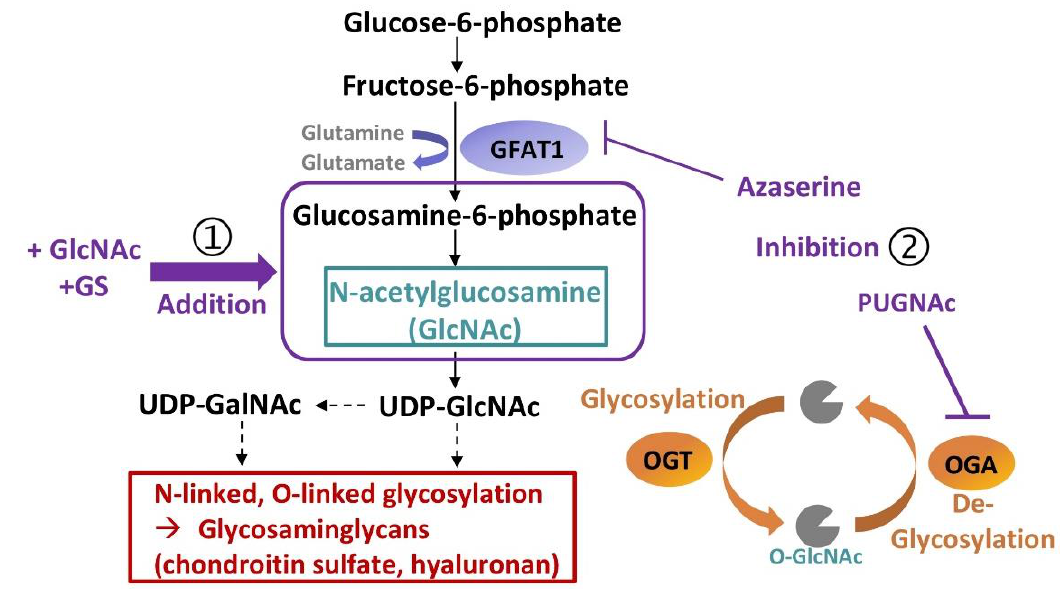
Figure 1. Schematic illustration of the hexosamine biosynthetic pathway (HBP), its role in glycosaminoglycan synthesis and potential therapeutic targeting. In the present study, the HBP is targeted in different ways: (1) glucosamine derivatives (N-acetylglucosamine (GlcNAc) or glucosamine sulfate (GS)) were added at different concentrations to enhance the bioavailability of the substrate for uridine diphosphate GlcNAc (UDP-GlcNAc) generation; (2) the rate-limiting enzyme, glutamine fructose-6-phosphate amidotransferase (GFAT1), was inhibited by means of Azaserine, while hydrolysis of O-GlcNAc residues (de-glycosylation) was suppressed using PUGNAc, a specific inhibitor of OGA. GalNAc = N-Acetylgalactosamine, OGA = N-acetylglucosaminidase, OGT = O-GlcNAc transferase, PUGNAc = O-(2-acetamido-2deoxy-D-glucopyranosylidene)amino-N-phenylcarbamate.